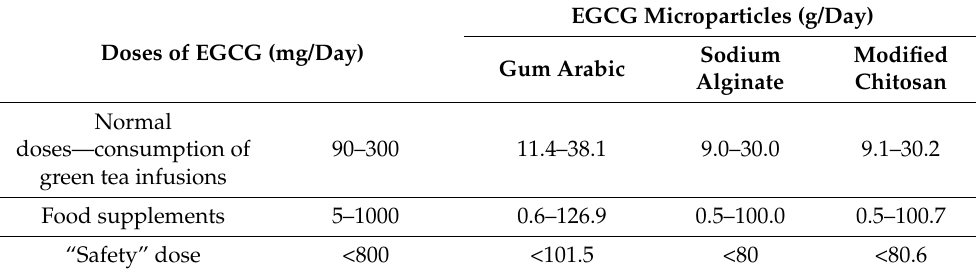
Table 4. Estimate of the amounts of EGCG microparticles corresponding to normal intake doses of